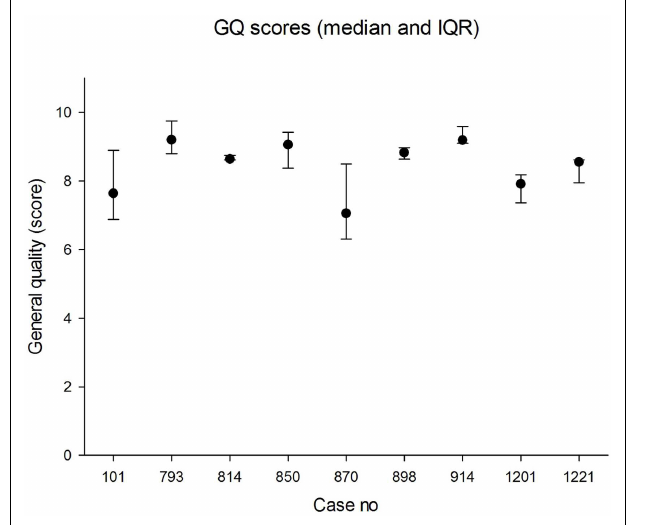
FIGURE 6 | Cusum of general quality score